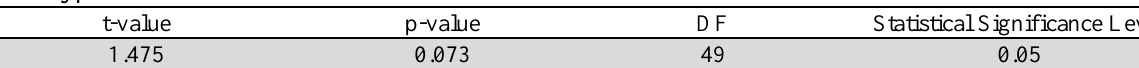
First hypothesis at 95% confidence level t-value p-value DF Statistical Significance Level 1.475